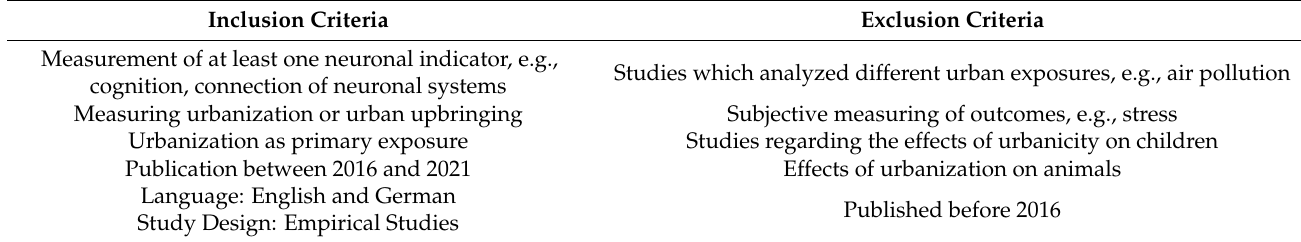
Table 1. Inclusion and exclusion